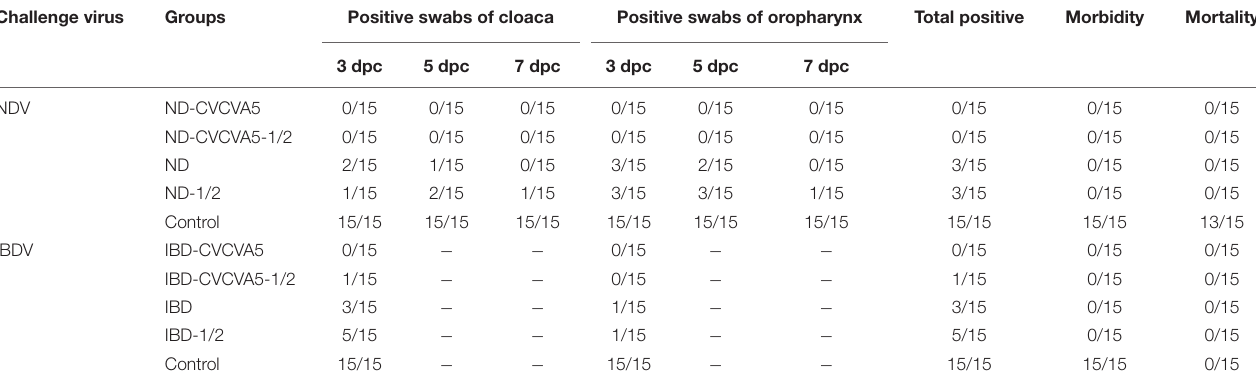
Control 15/15 Chickens in the ND challenge groups were subcutaneously inoculated 10 5.0 ELD 50 of F48E8 virulent viruses at 4 weeks post vaccination (wpv). The clinical signs of all birds were monitored for 14 days. Oropharyngeal and cloacal swab samples were collected at 3, 5, and 7 days post-challenge (dpc) for virus isolation. Birds in the IBD challenge groups were inoculated intraocularly with 10 BID 50 BC6/85 viruses at 4 wpv. The monitoring period was only 3 days and the swab samples were collected at 3 dpc. The morbidity was counted with the clinical signs of challenge chickens. − , not